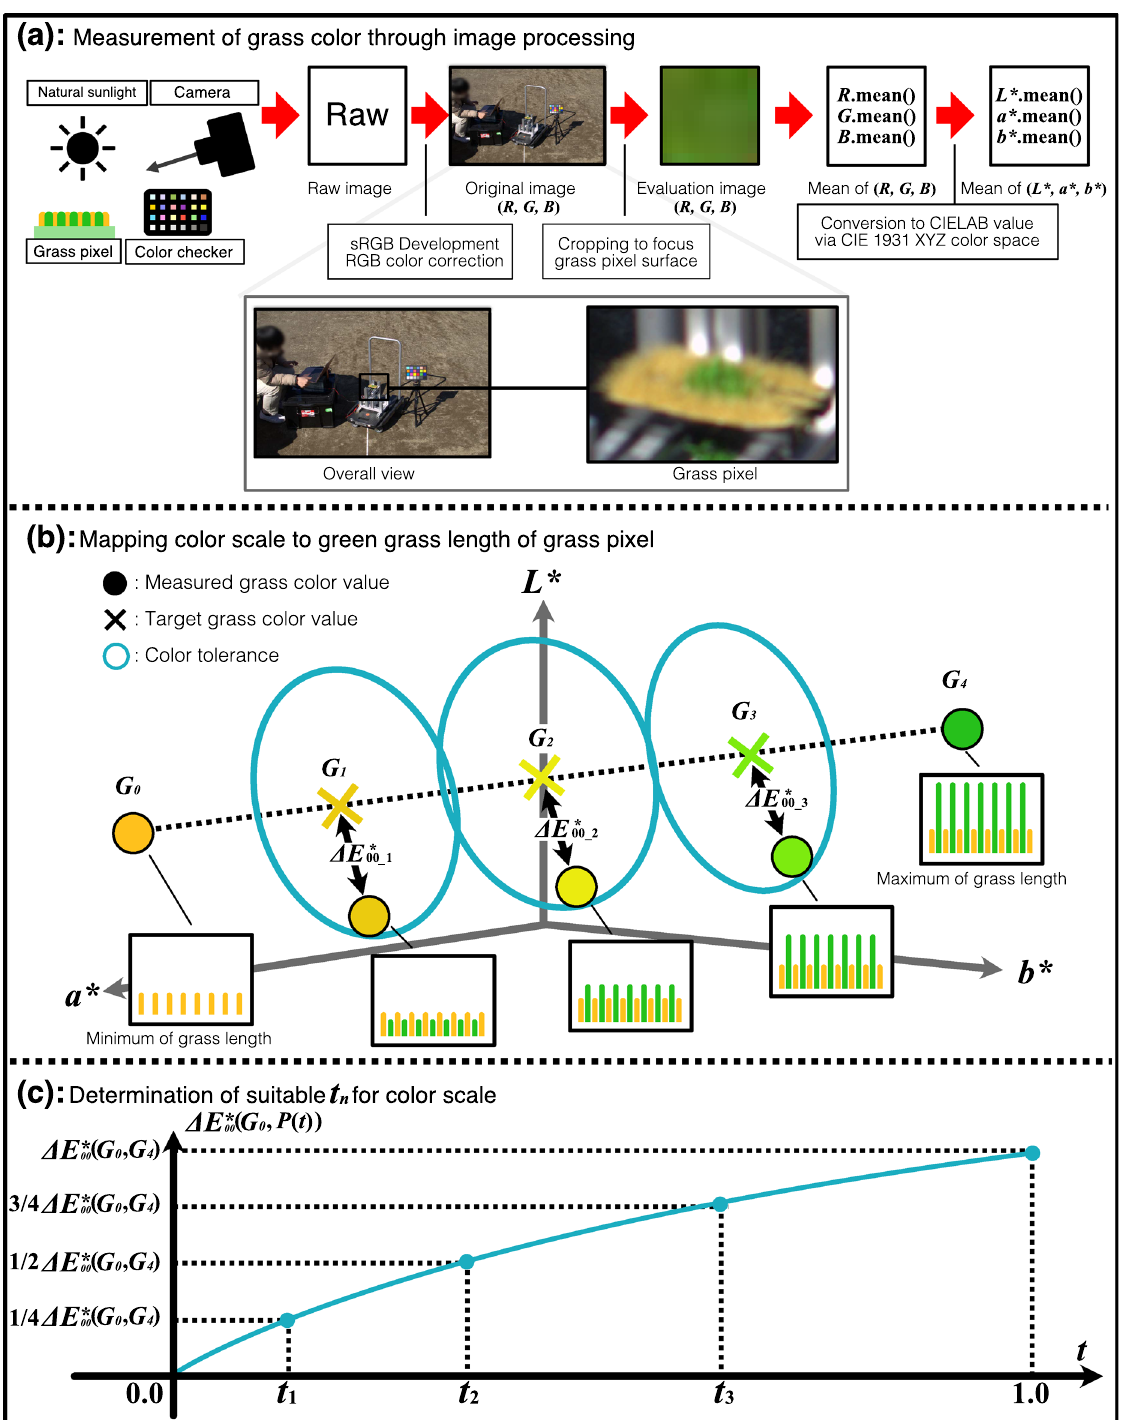
Figure 4. Overview of grass color scale setting procedure. ( a ) The grass color of a grass pixel is measured as a CIELAB value through image processing. ( b ) Measured grass color values are compared with target grass color values to map the grass length of the grass pixel to a color scale with five levels. ( c ) To calculate the target grass color value, t n suitable for G n is determined so that � E ∗ 00 ( G 0 , P ( t n )) is ( n / 4 ) · � E ∗ 00 ( G 0 , G 4 ) . This figure was created using Serif Affinity Designer version 1.10.0 (https:// affin ity. serif. com/ en-